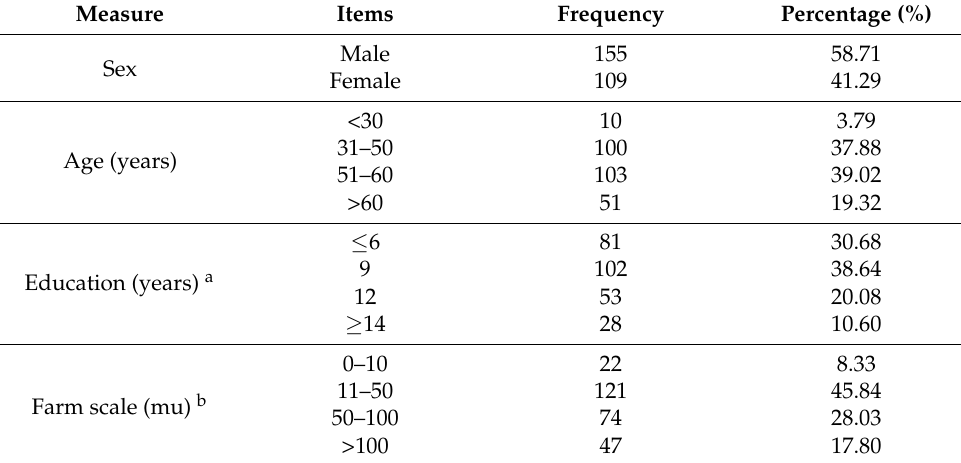
Table 1. Survey farmers demographics ( N = 264).